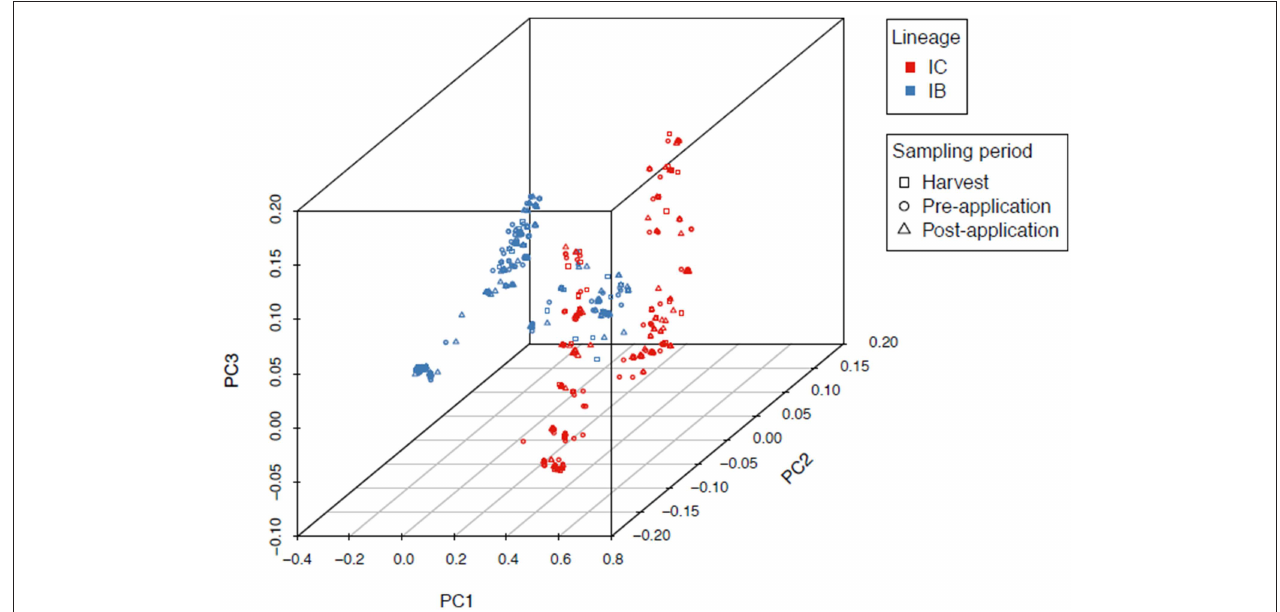
FIGURE 2 | Principal component analysis of 1,282 A. flavus isolates showing two distinct clusters identified as lineages IB and IC based on MLST loci ( trpC , AF17, and mfs ). Admixture between IB and IC is indicated as a mix of red and blue lineage colors in the middle of the first principal component axis (PC1). There was a significant ( P < 0.00001) association between lineage and sampling